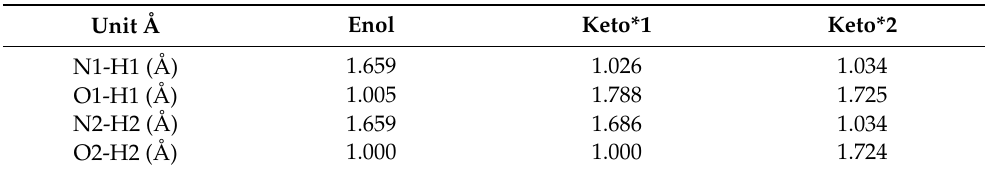
Figure 1. The optimized structure of BP(OH) 2 in the S 0 and S 1 states at the B3LYP/def2TZVP (gd3bj) IEFPCM (Hexane) level. Enol form: the initial conformation at the S 0 state; Keto*1 form: the conformation based on single ESIPT in the S 1 state; Keto*2 form: the conformation based on double ESIPT in the S 1 state. The blue atom represents N, the cyan atom represents C, the grey atom represents H, and red atom represents O. Table 1. Obtained primary bond lengths for the optimized structure of BP(OH) 2 at the S 0 and S 1 states (Unit